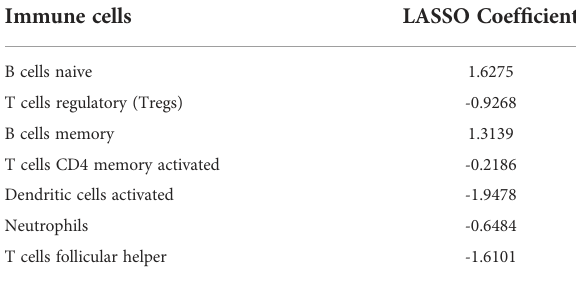
TABLE 1 LASSO analysis of 7 candidate immune cells.